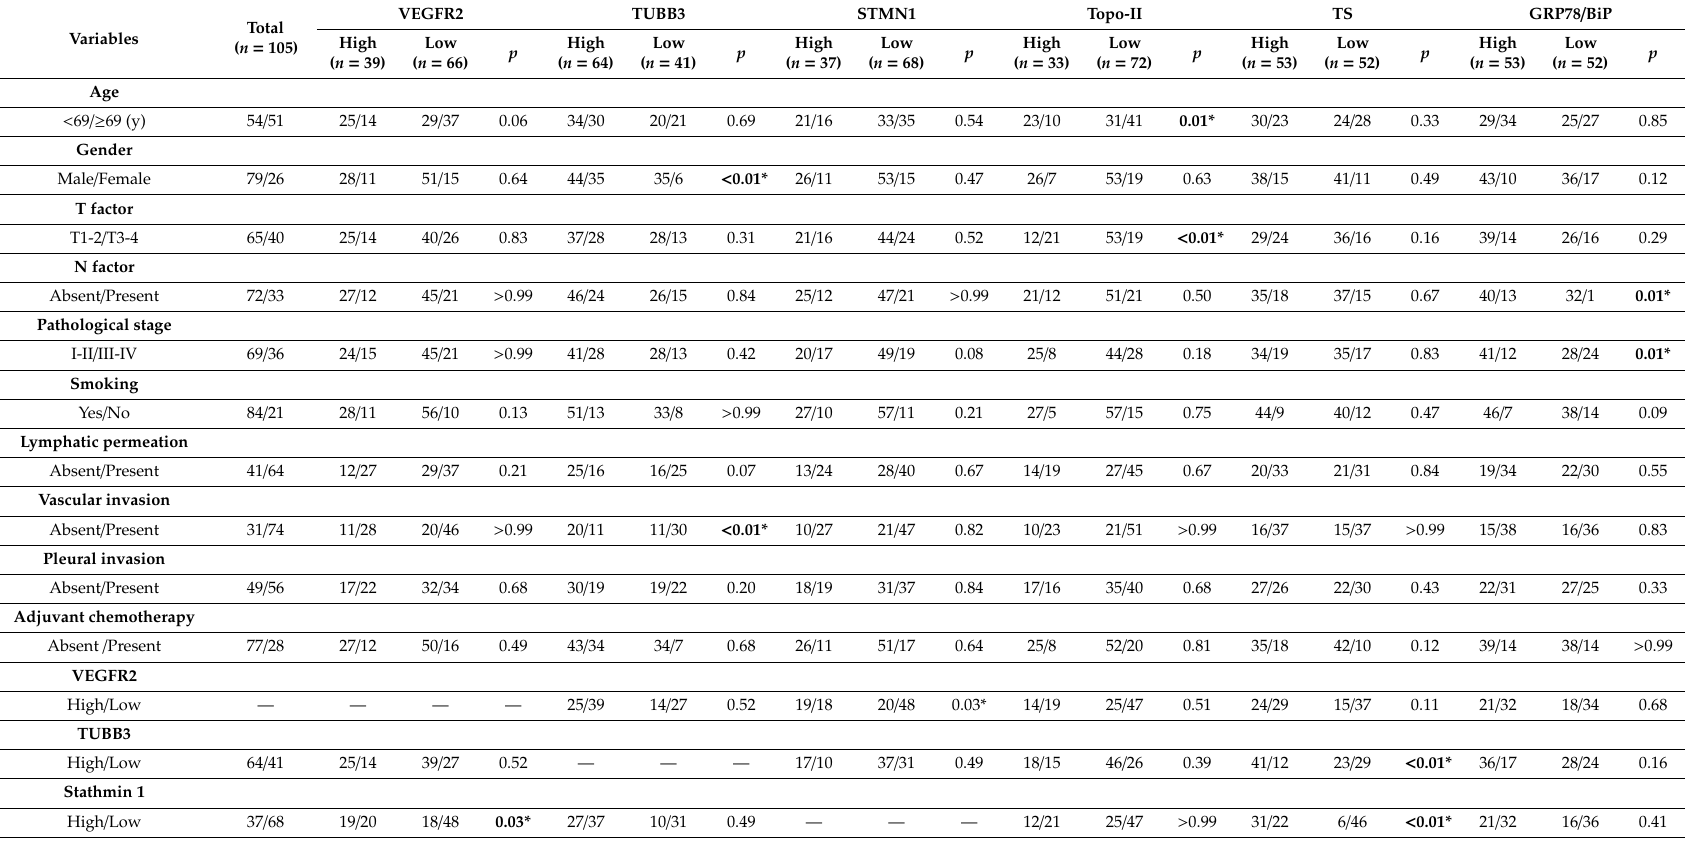
Table 2. Patient demographics according to di ff erential levels of target